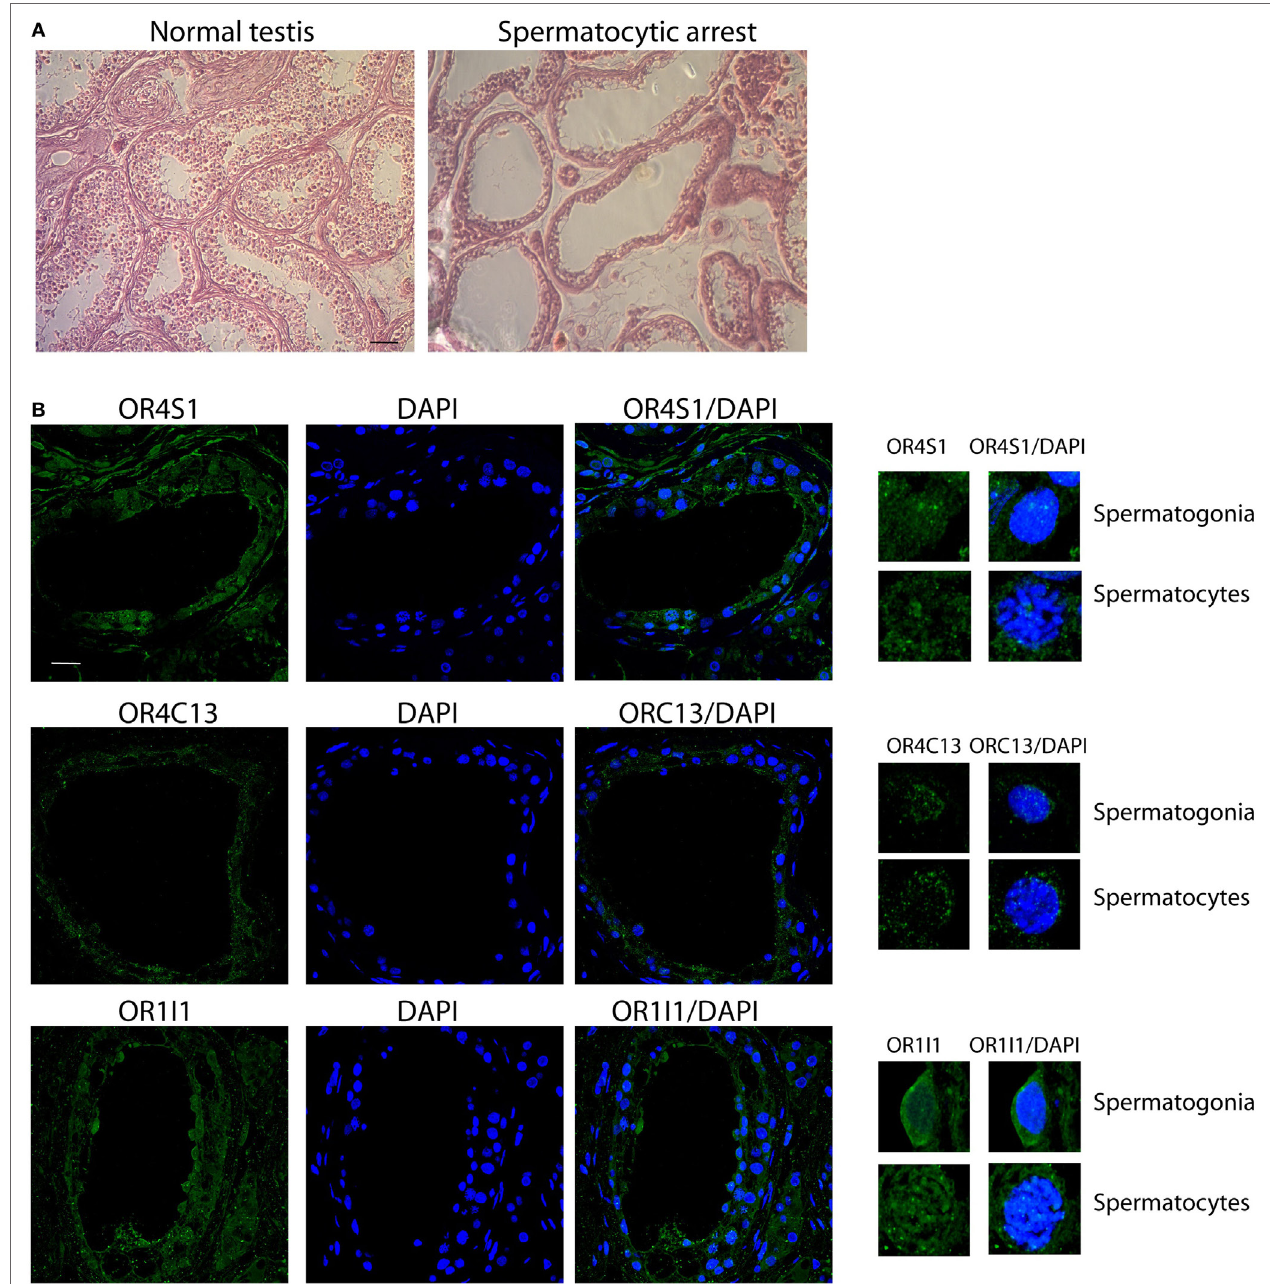
FigUre 4 | (a) Representative images (H&E) of normal or pathological testicular tissue (spermatocyte maturative arrest), scale bar 200 µm. (b) Confocal analysis of OR4S1, OR4C13, and OR1I1 protein expression in testicular tissue from patients with secretive azoospermia and findings of spermatocyte maturative arrest. Nuclei were counterstained with DAPI (scale bar 25 µm). Representative panels showing spermatogonia and spermatocytes at high magnification are included in the